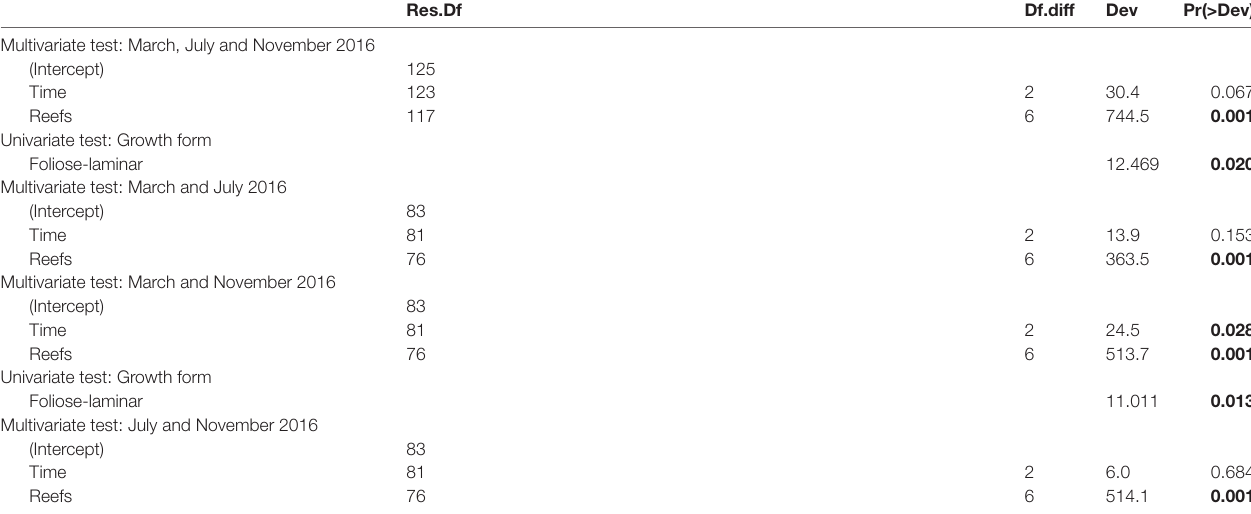
TABLE 3 | Summary statistics for analysis of coral growth forms pooled among reefs across months (March, July and November 2016).